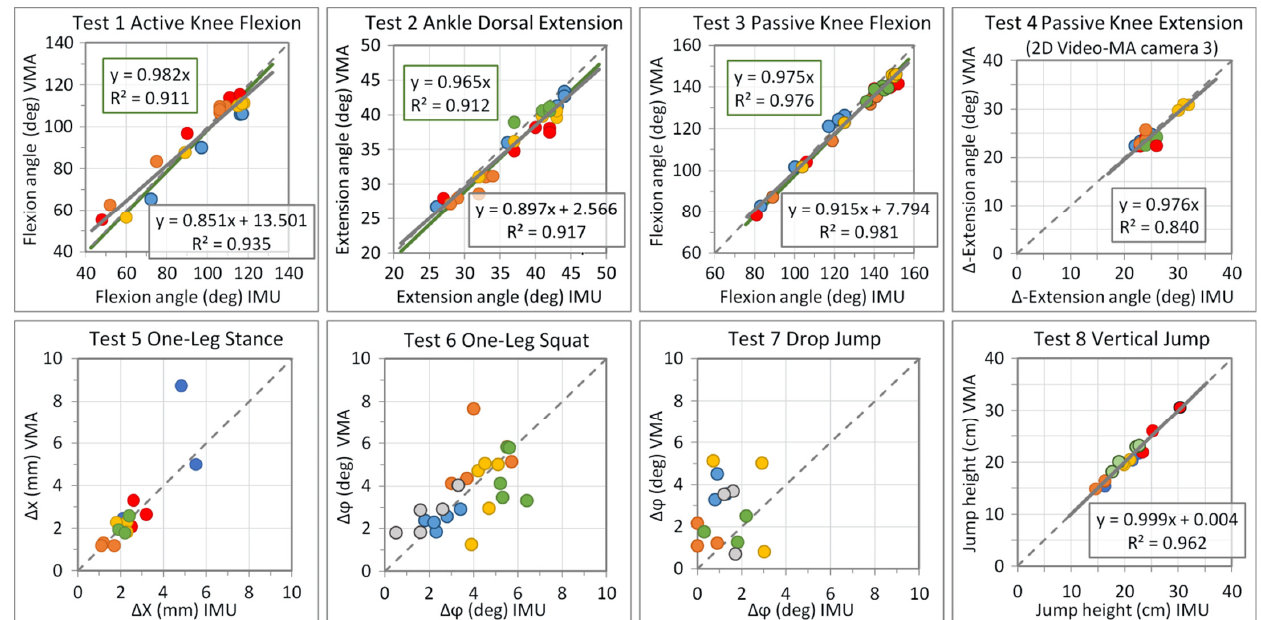
Figure 3. Comparison of the measurement results between IMU sensor and video-MA. The control points represent the measurements with both systems and lie exactly on the diagonal if the score values of the IMU sensor and the video-MA are perfectly matched, while different colors represent multiple measurement points of the test persons. Table 1. Measured test scores of IMU system (IMU) and video-MA (VMA). All numerical values are averages over all volunteers and all test repetitions. SD (standard deviation) and RMS (root mean square) are variations of the score value differences between IMU and VMA. Percentage SD (%) and RMS (%) are differences relative to the VMA score.